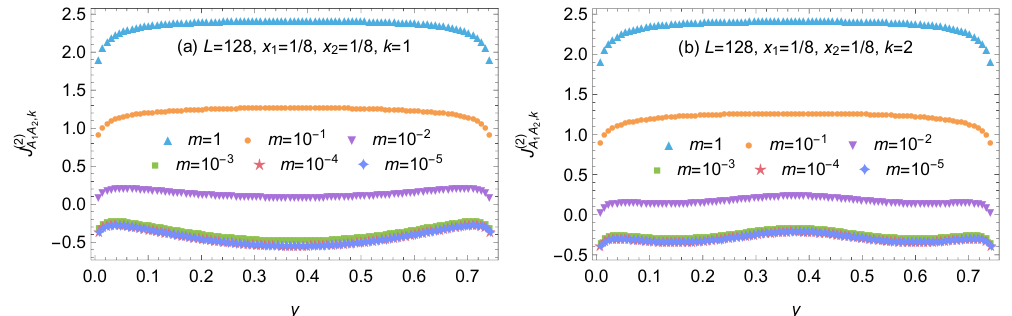
Figure 7 . The second Rényi mutual information in the single-particle state of massless limit of the harmonic chain. We verify that the excited state double-interval Rényi entropy has the same IR divergent term as that in the ground